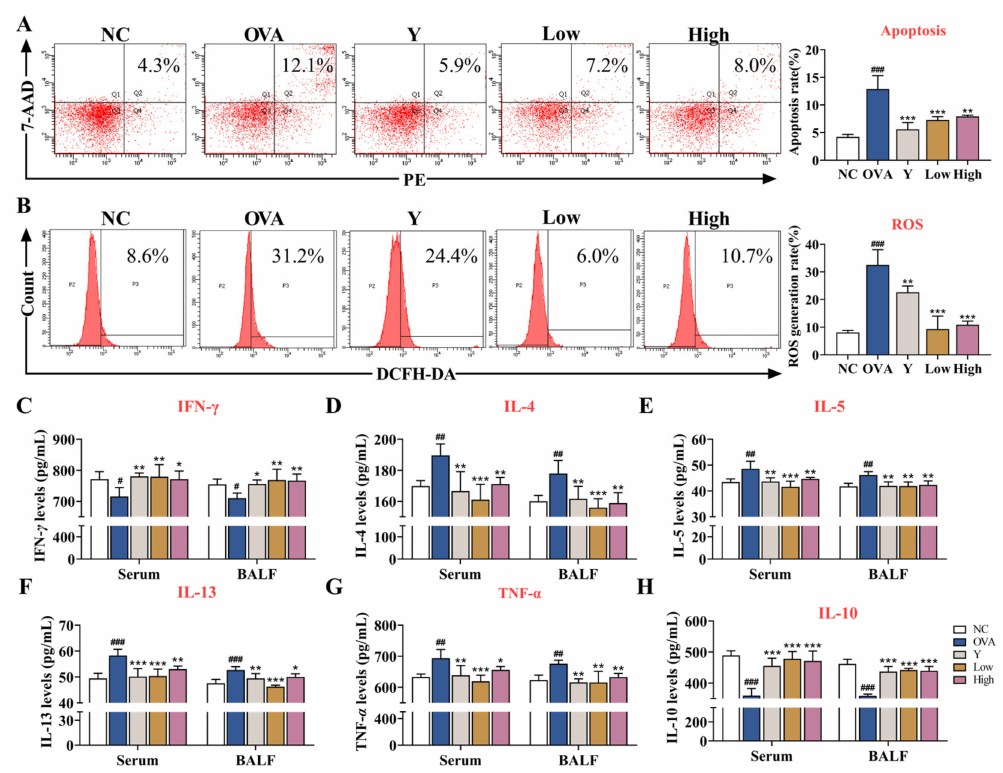
Figure 3. EB-A alleviated lung injury and inflammation in OVA-induced mice. ( A ) The levels of apoptosis in lung cells were tested by flow cytometry. ( B ) The levels of ROS in lung cells were tested by flow cytometry. ( C – H ) Graphs show levels of IFN- γ , IL-4, IL-5, IL-13, TNF- α , and IL-10 in serum and BALF. All data are shown as mean ± SD. # p < 0.05, ## p < 0.01, ### p < 0.001, compared with the NC group; * p < 0.05, ** p < 0.01, *** p < 0.001, compared with the OVA